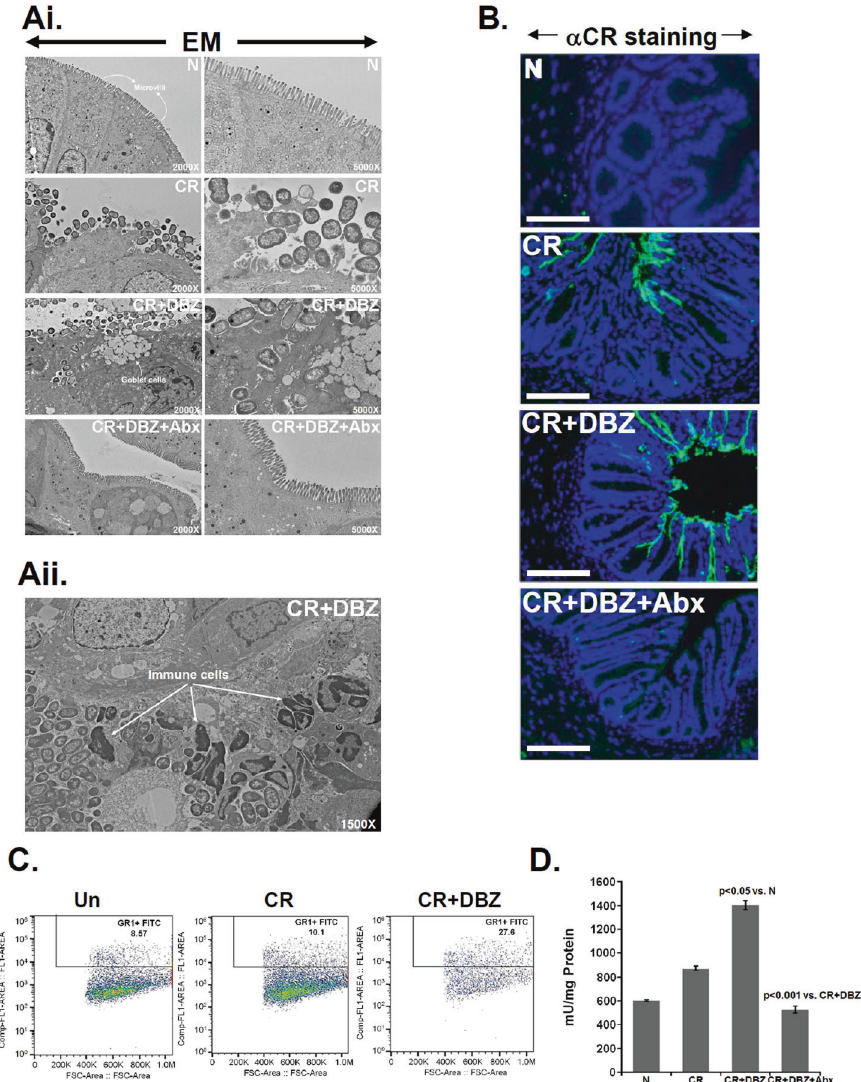
Fig. 5 Effect of Notch blockade on bacterial colonization, neutrophil recruitment, and myeloperoxidase (MPO) activity. Ai Electron microscopy of distal colons isolated from uninfected (N), CR-infected (CR), CR + DBZ-treated (CR + DBZ), or CR + DBZ plus antibiotics (CR + DBZ + Abx)-treated Rag-1 − / − mice. Loss of microvilli structure in response to CR infection was exacerbated following Notch inhibition in the CR + DBZ group with clear bacterial invasion into the sub-mucosa. Antibiotics (Abx) treatment restored the microvilli. Aii represents the EM of distal colon from the CR + DBZ group showing interaction of bacteria with immune cells (6 mice/group; n = 3 independent experiments). B Representative images showing bacterial staining by anti-CR antibody ( α CR). C Flow cytometry for Gr1(Ly6G) + cells was performed in the colon tissues of uninfected (N), CR-infected (CR), or CR + DBZ-treated (CR + DBZ) Rag-1 − / − mice. D MPO activity was measured in the colonic homogenates of the indicated groups using a Fluoro MPO Detection Kit (6 mice/group; n = 3 independent